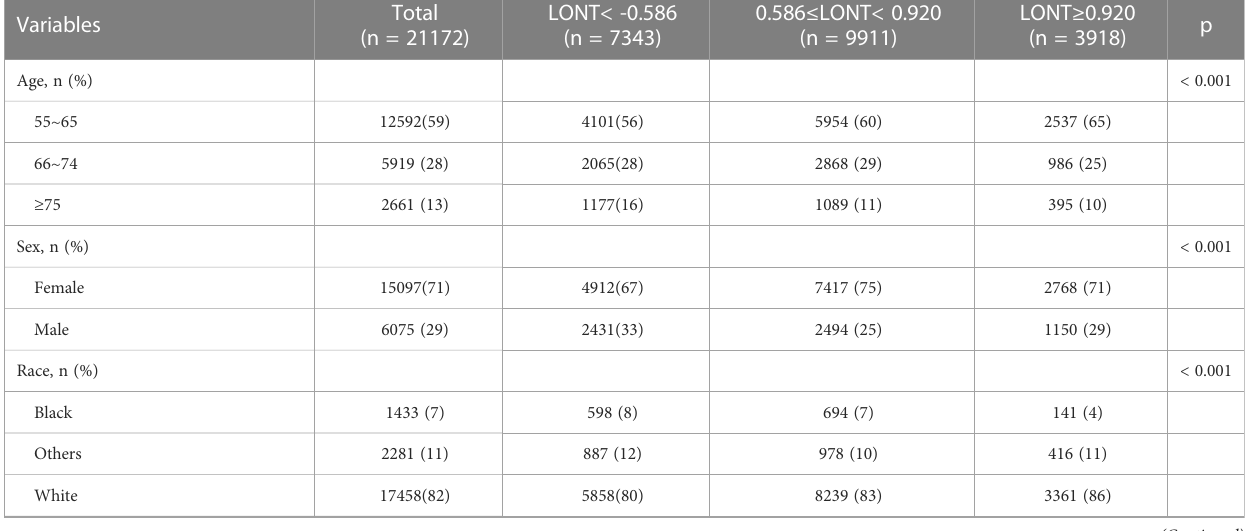
TABLE 1 Demographic and clinicopathologic characteristics of the study cohort.